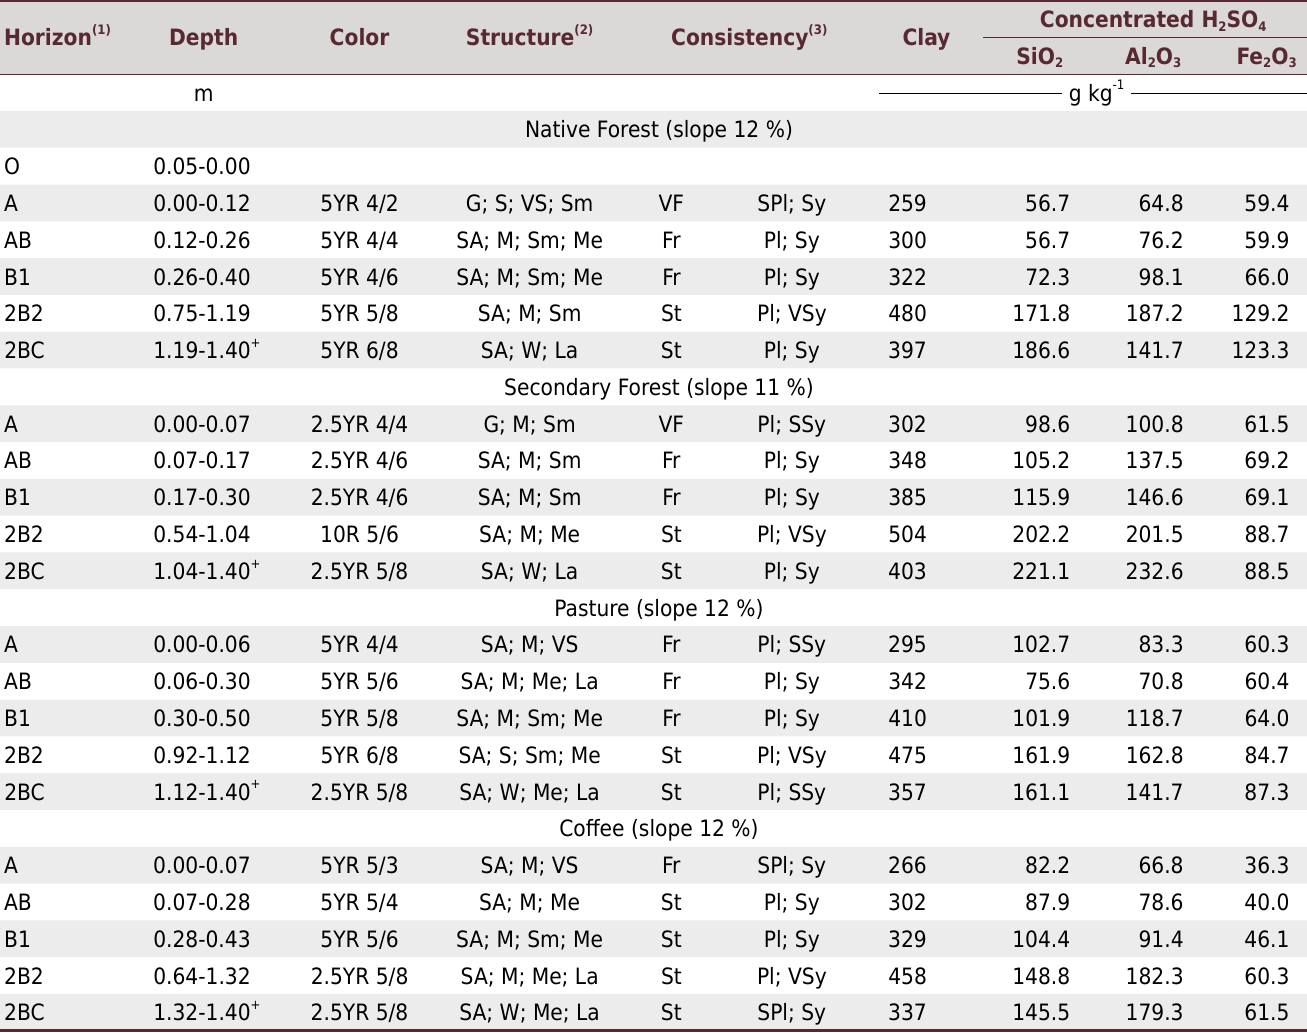
Table 1. Morphological properties of selected profiles and mean physical and chemical soil properties for four management systems in southern Amazonia, Brazil Horizon